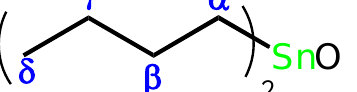
Table 1. Crystal data and structure refinement parameters for complex 1 .